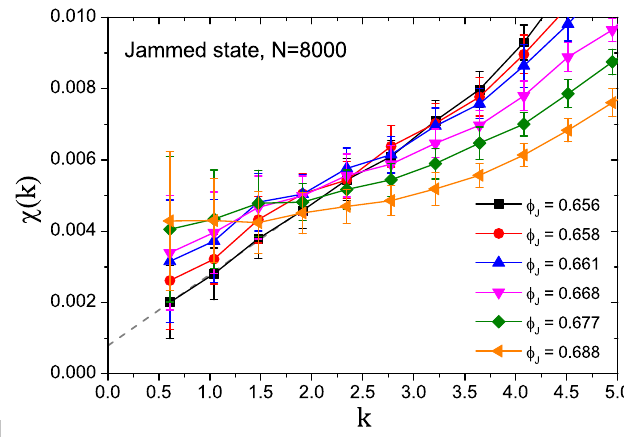
Figure 9: Zoom in the small k region of the spectral density χ ( k ) for jammed states shown in Fig. 8(d). The error bars represent the standard deviation obtained from sample to sam- ple fluctuations. The gray dashed line is a linear fit for φ χ ( k → 0 ) = 7.9 × 10 − 4 for the lowest φ